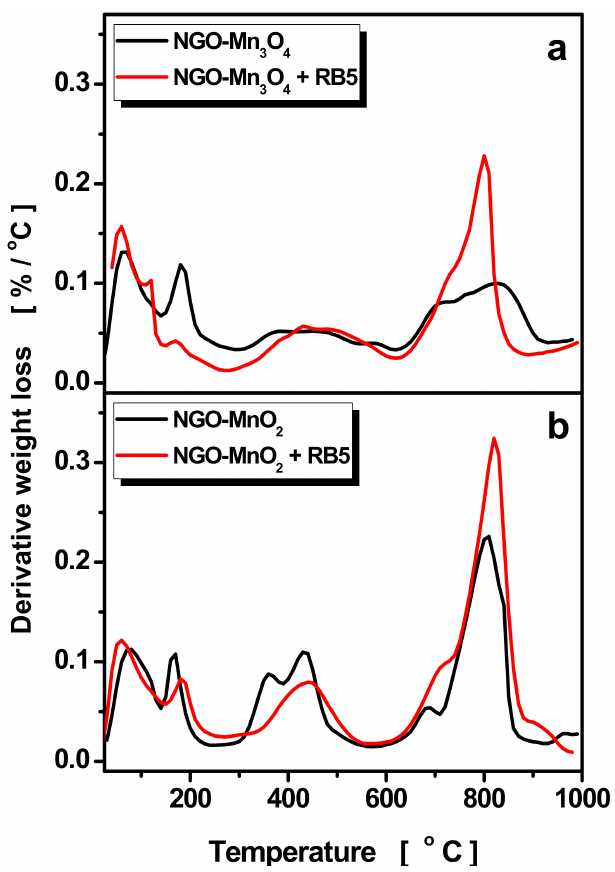
Figure 11. DTG curves for ( a ) NGO–Mn 3 O 4 and ( b ) NGO–MnO 2 modified composites in absence and presence of